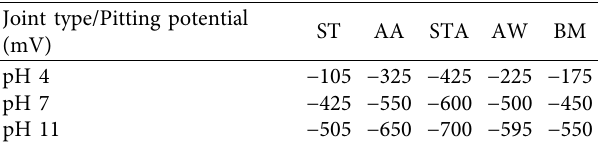
Table 5: Pitting potential values of P-CMT welded AA2014 alu- minium alloy joints.